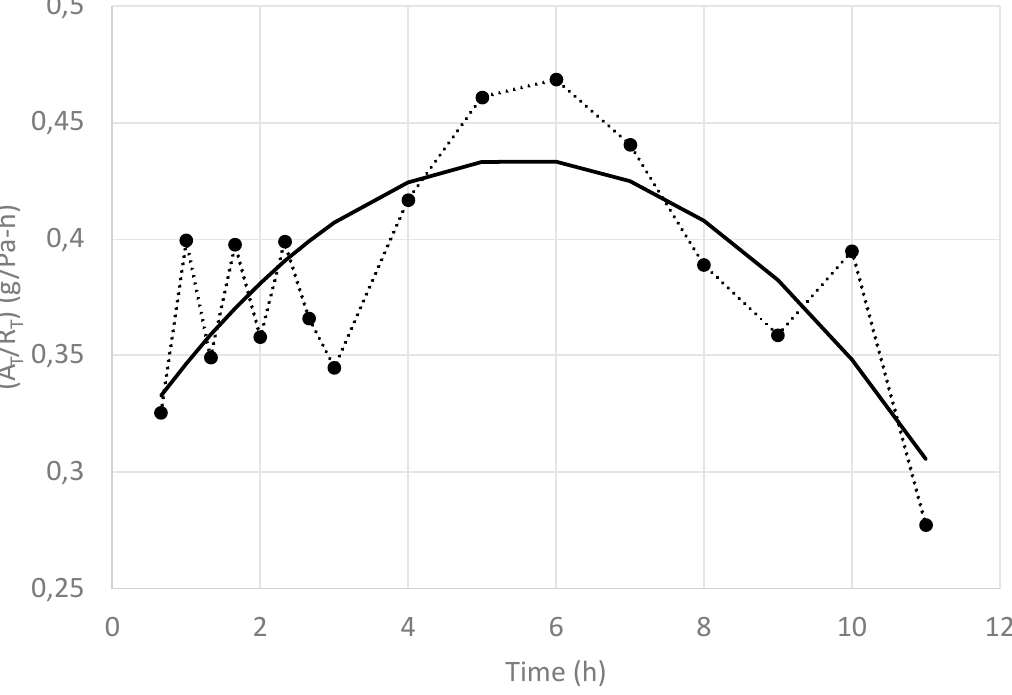
Figure 7. Values of (A T / R T ) along the freeze-drying time ( • ) and its corresponding tendency line ( — ) of whole nontreated blueberries.